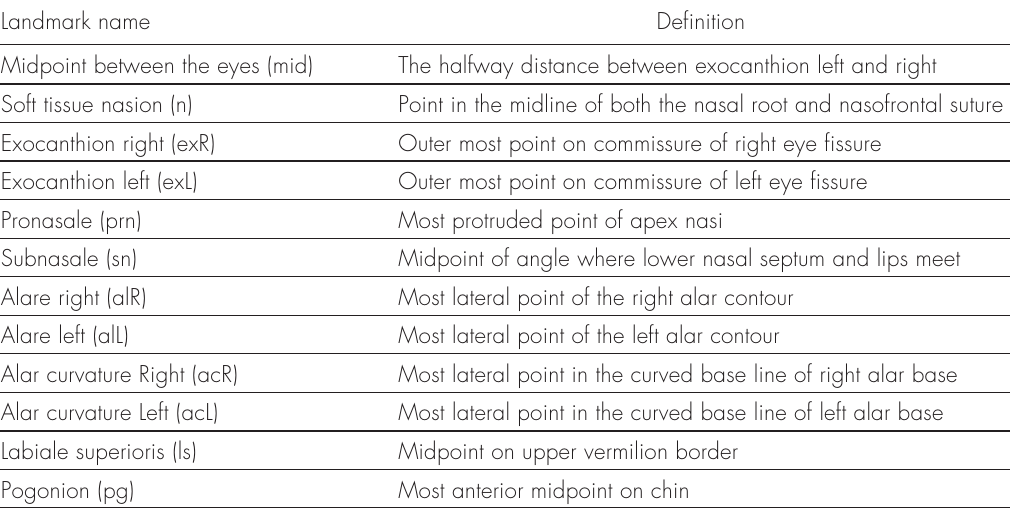
Table II. Facial Landmarks.